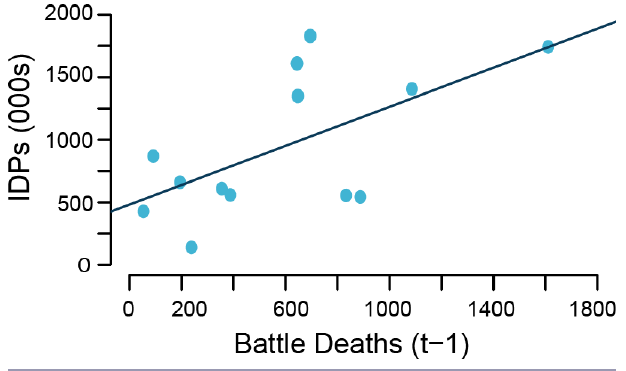
Fig. 5 . Increasing conflict intensity, measured by conflict- related deaths, is correlated with greater internal population displacement (IDP). Battle death data are from the Uppsala Conflict Data Program (UCDP 2015). The IDP data are from the Norwegian Refugee Council and Internal Displacement Monitoring Centre (2012). Lagged (one-year) battle deaths and contemporaneous IDP populations are correlated at r = 0.62, p <